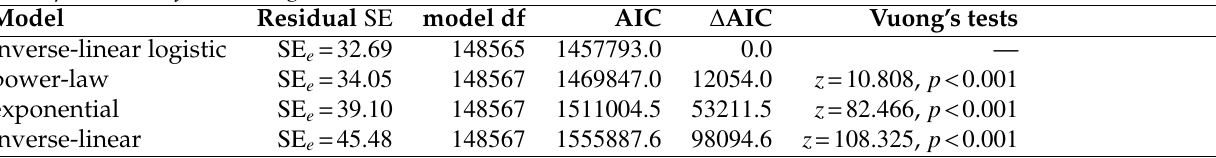
Tests of nonlinear model fits to saccades and microsaccades . For all ∆ AIC the inverse-linear logistic model is the base as it yields the smallest AIC criterion. Vuong’s tests (last column) compare all other models to the inverse-linear logistic fit. Data from Experiment 3 (free viewing @ 500